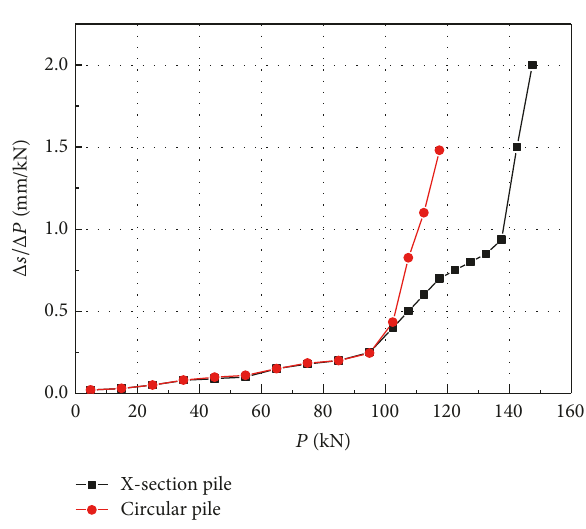
Figure 5: Load-settlement curves (curves of 𝑃 − 𝑠 ).